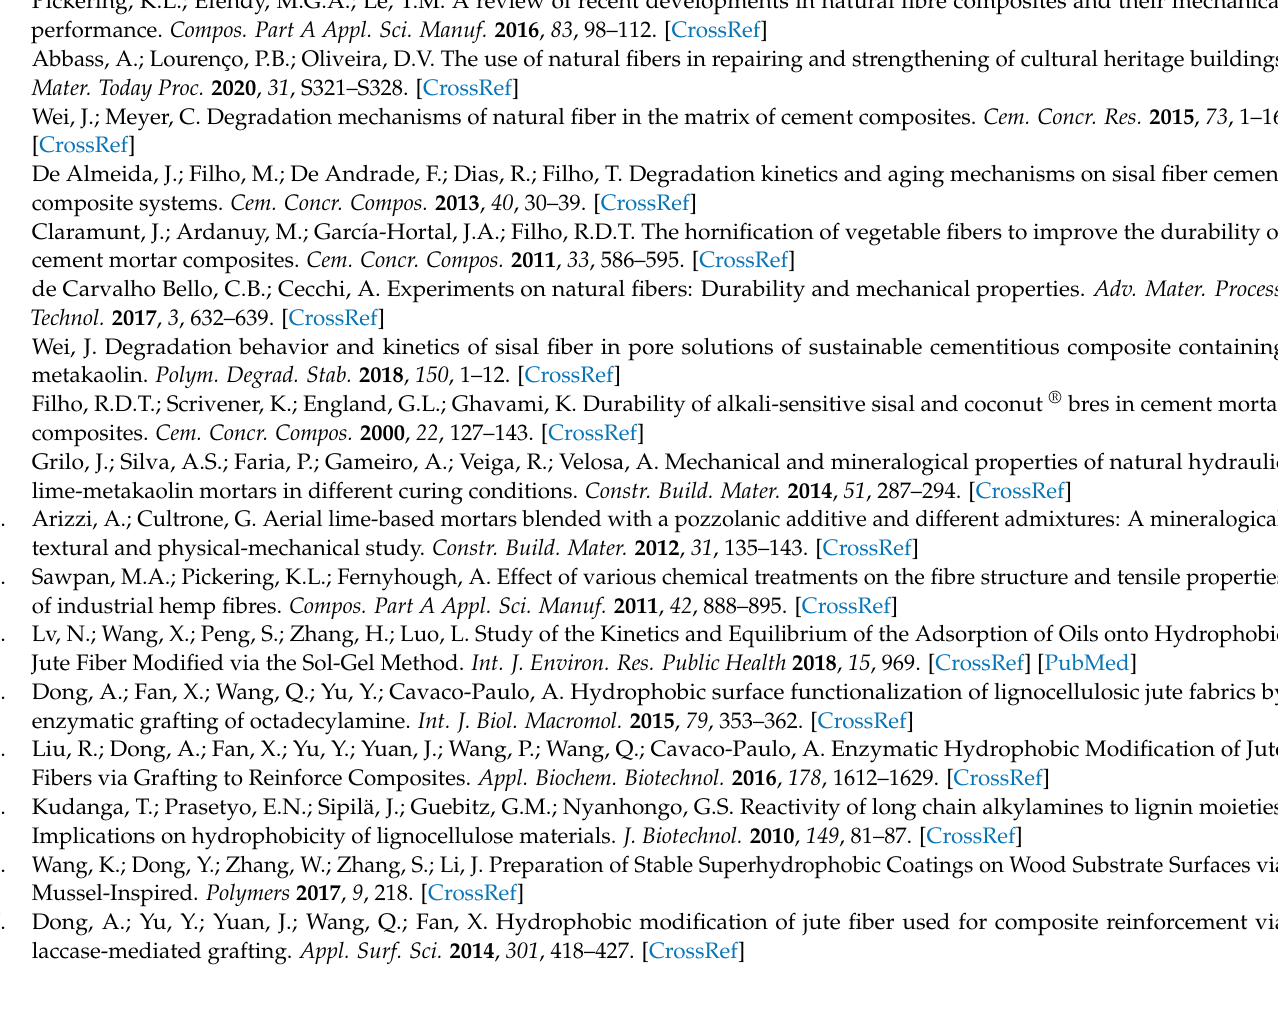
Semi-quantitative estimate of crystallinity of sisal fibers, Table S3: Semi-quantitative estimate of crystallinity of hemp fibers, Table S4: Tensile properties of flax yarns, Table S5: Tensile properties of sisal yarns, Table S6: Tensile properties of hemp